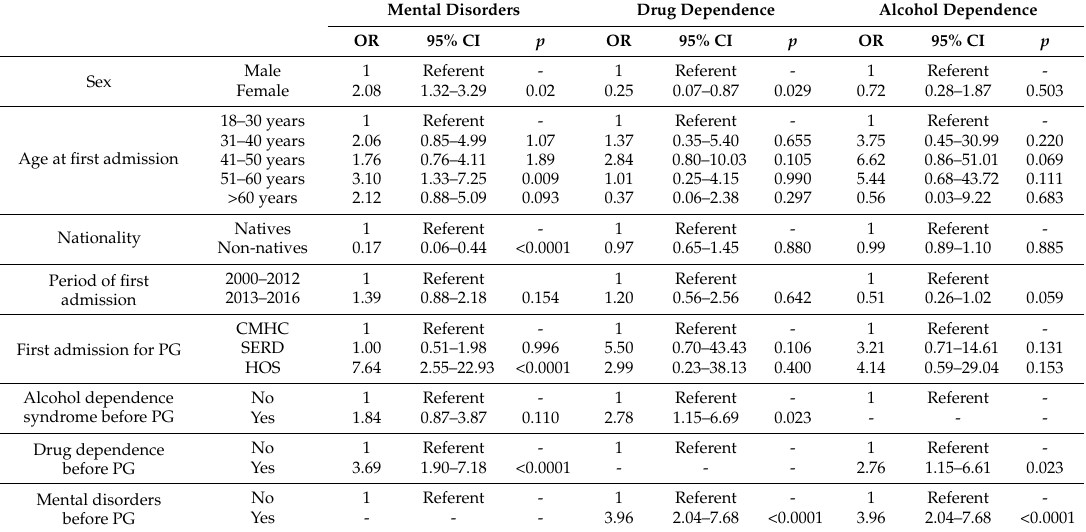
Table 3. Mental disorders, drug dependence and alcohol dependence before pathological gambling: logistic regression